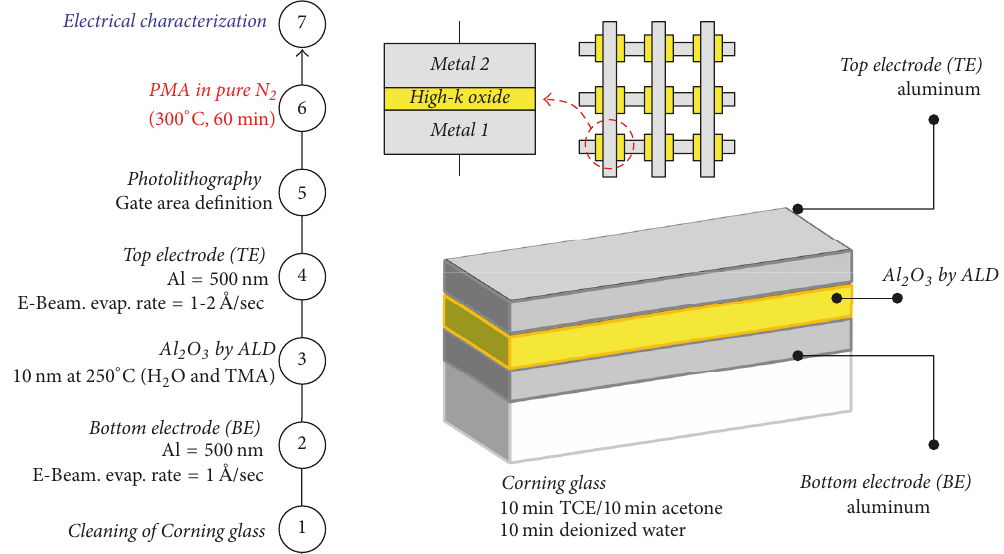
Figure 2: Process flow for fabrication of Al/Al 2 O 3 /Al stacked structures using a maximum temperature of 300 ∘ C, ideal for BEOL processing. Traverse cut of an ideal MIM device (where M1 = M2 = aluminum) as well as possible MIM arrays that could be densely integrated within the BEOL stages of an integrated circuit.